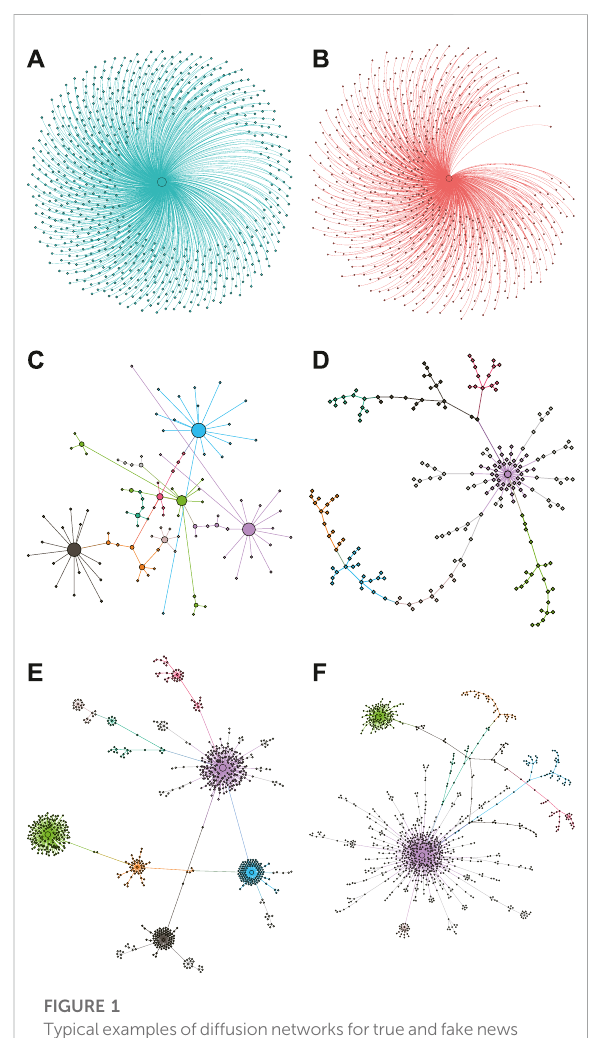
FIGURE 1 Typicalexamplesofdiffusionnetworksfortrueandfakenews items. (A) A true news diffusion network with 630 nodes and v ~ 2 (purebroadcast). (B) Afakenewsdiffusionnetworkwith600nodes and v ~ 2 (pure broadcast). (A,B) are both advertisements. (C) A true news diffusion network with 102 nodes, nine communities, and v ~ 7.142. The content talks about the descendant of Confucius. (D) A fake news diffusion network with 207 nodes, 17 communities and v ~ 9.895. The content talks about Red Cross Society of China. (E) A true news diffusion network with 800nodes,21communities,and v ~5.763.Thecontenttalksabout a North Korean diplomat who joined South Korea. (F) A fake news diffusion network with 997 nodes, 63 communities, and v ~ 7.748. The content talks about some people using babies to make soup. Different colors represent different communities in the